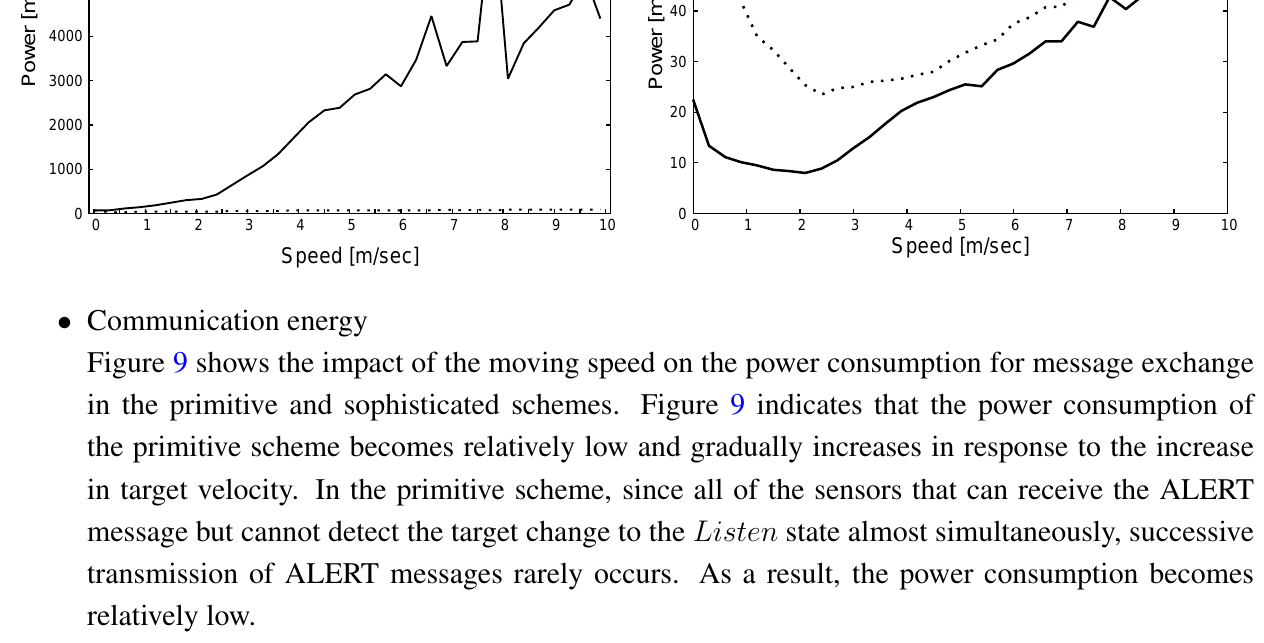
Figure 8. Power consumption (state), E . s